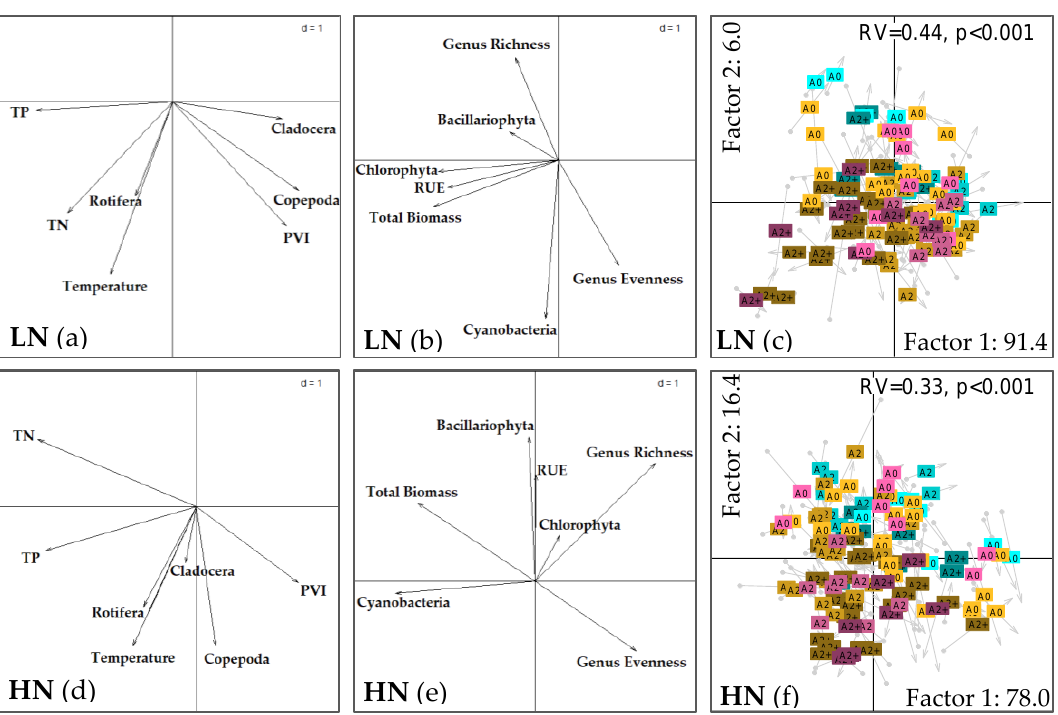
Figure 5. Co-Inertia (COI) ordination plots for LN and HN. ( a , d ) explanatory variables, ( b , e ) phytoplankton response variables. The length and direction of the vectors specify the weights of the variables. ( c , f ) represent the concordance between panel a and b (colour codes: cyan gradient—before period (A0: light cyan, A2: cyan, A2 + : dark cyan), yellow gradient—during period (A0: light yellow (no exposure to HW), A2: yellow, A2 + : dark yellow), pink gradient—after period (A0: light pink, A2: pink, A2 + : dark pink)). Arrows in ( c , f ) present the relative position of samples within the two datasets (explanatory and response).